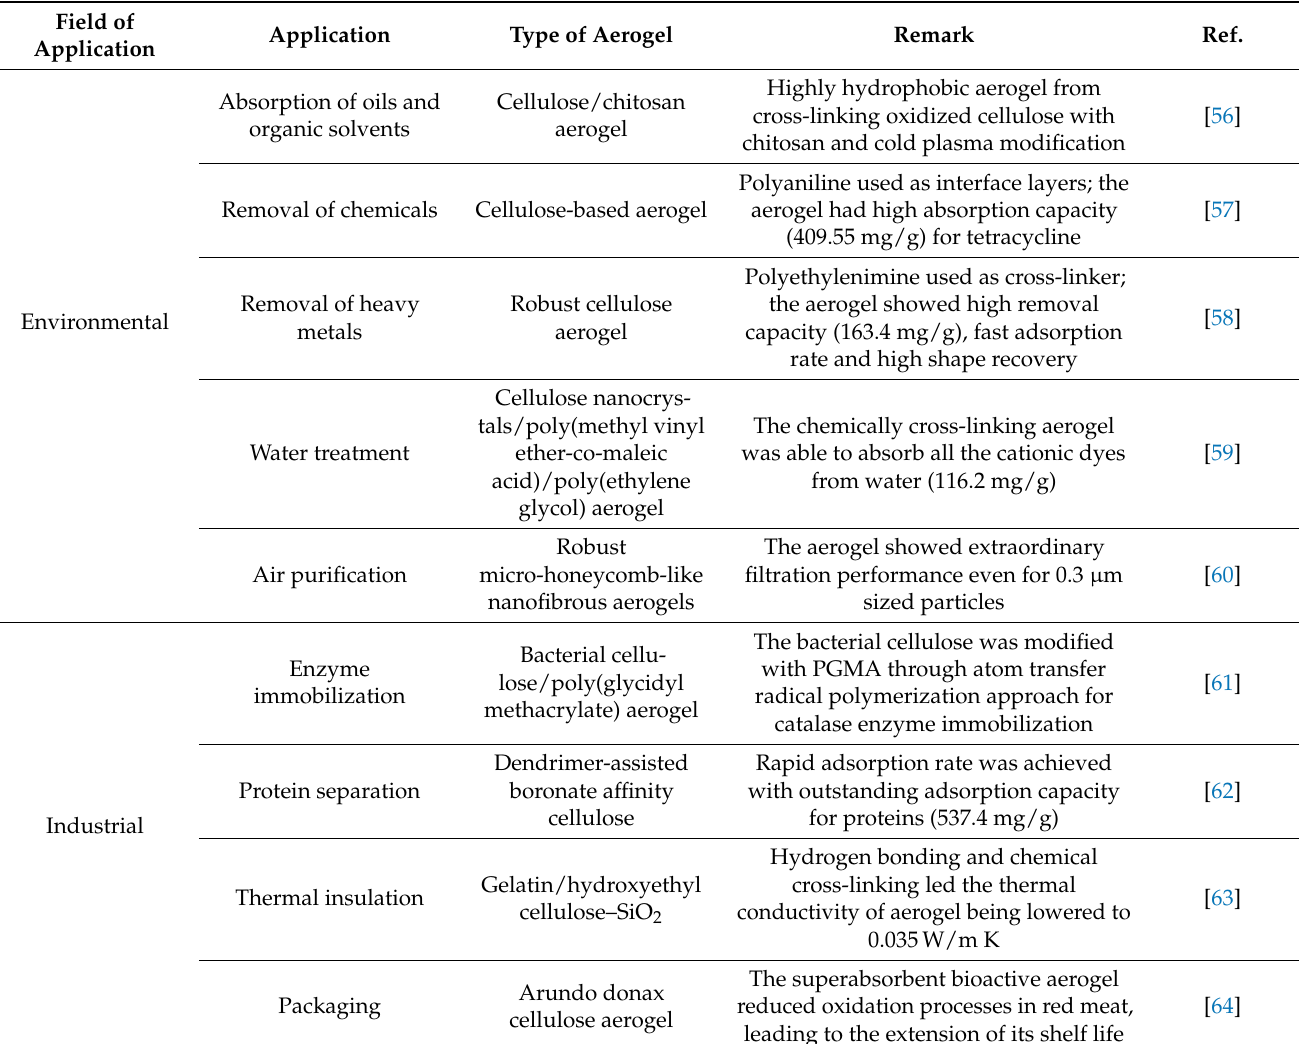
Table 1. The role of nanocellulose-based aerogels in different